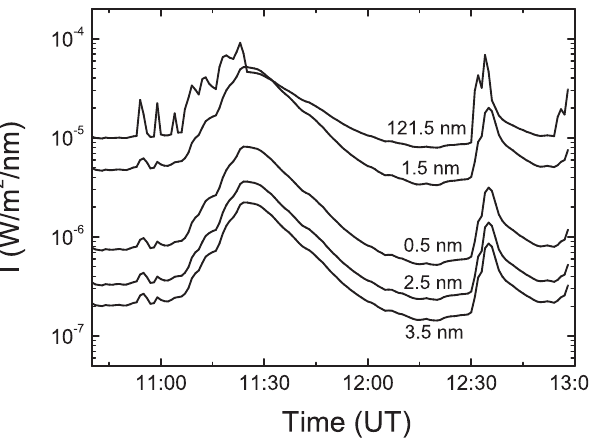
Fig. 2. Electron concentrations at different altitudes related to the two flares of classes C7.7 and C3.0.